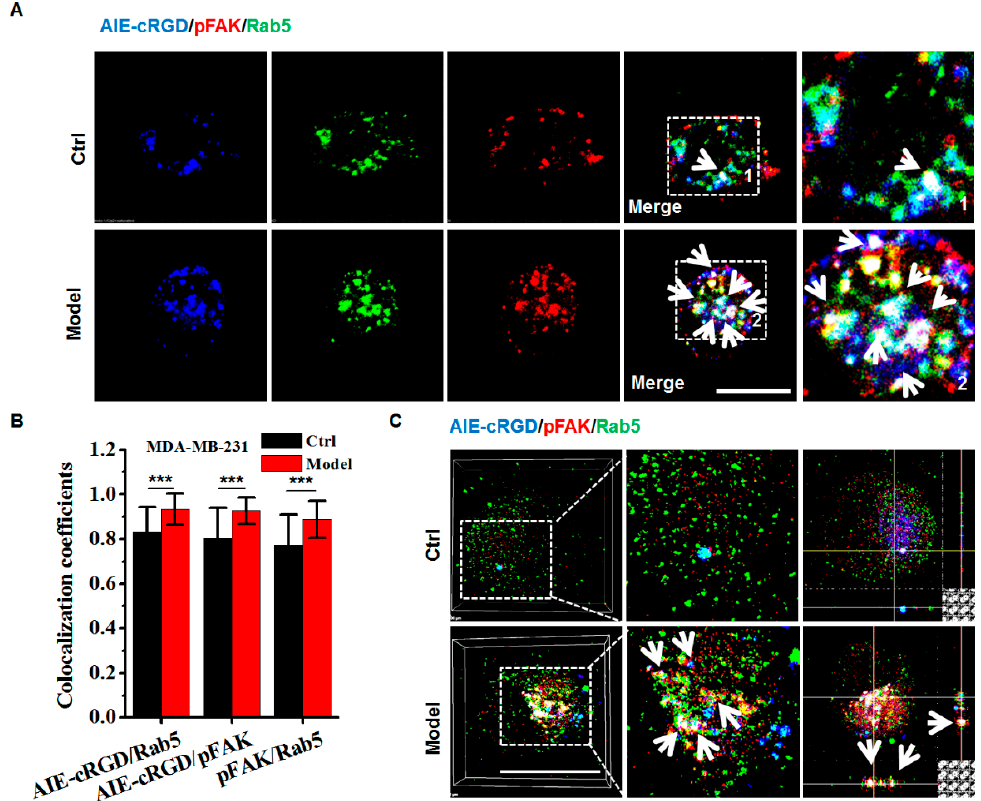
Figure 6. Assaying the resisting anoikis in model cells using the AIE-cRGD. ( A ) Confocal images of MDA-MB-231 cells stained with AIE–cRGD (blue), pFAK (red), and Rab5 (green), respectively. The model cells were cultured in poly-HEMA-coated six-well plates for 24 h, whereas the control was in untreated six-well plates. The white arrows showed the colocation of the AIE-cRGD, pFAK, and Rab5. Bar = 20 μ m. ( B ) Colocalization intensity statistic of AIE–cRGD and Rab5, AIE–cRGD and pFAK, and pFAK and Rab5. *** p < 0.001 represent significant differences compared with the control group. ( C ) Confocal 3D images of MDA-MB-231 stained with AIE–cRGD, Rab5, and pFAK. The white arrows showed the colocation of the AIE-cRGD, pFAK, and Rab5. Bar = 20 μ